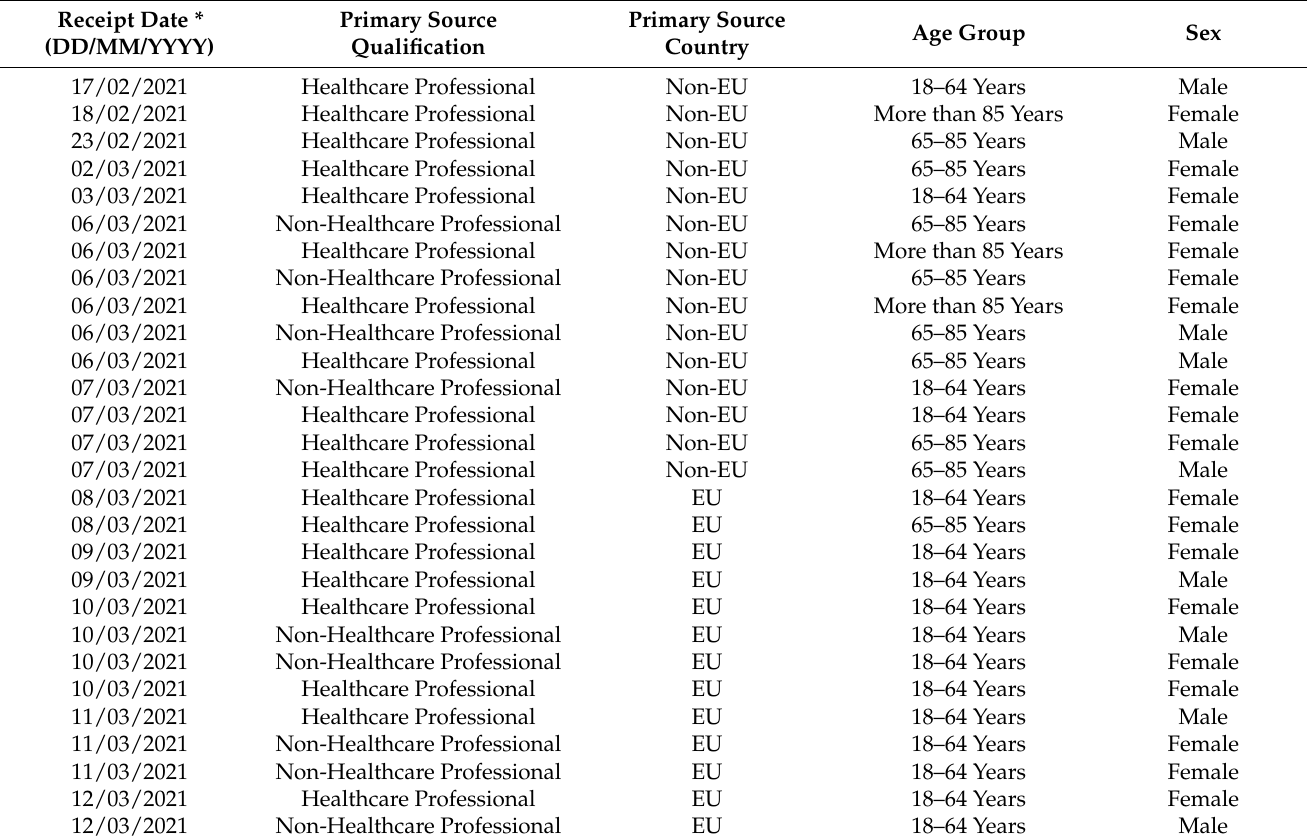
Table 2. Detail of EV database reported AstraZeneca vaccine ADRs ( N =